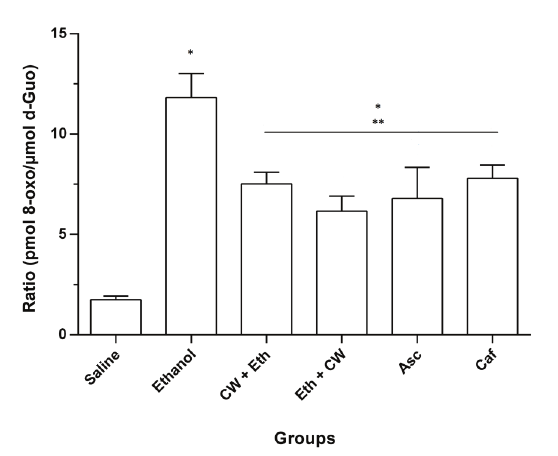
Figure 7 - Effect of CW, ascorbic and caffeic acid in the 8-oxo-2’-desoxiguanosinre DNA concentrations in liver of rats treated by ethanol. Eth – 2.5 mL/Kg of solution 35%; CW+Eth – 3 mL/Kg of coconut water followed by 2.5 mL/Kg ethanol; Eth+CW – 2.5 mL/Kg of ethanol followed by 3 mL/ Kg of coconut water; Asc + Eth – 3 mL/Kg of solution 25 µg/ µL followed by 2.5 mL/Kg of ethanol; Caf + Eth – 3 mL/Kg of solution 100 µg/µL followed by 2.5 mL/Kg of ethanol. The data are average ± S.D. for five animals. Means values were significant different for p<0.05; (*) different when compared with the saline group p<0.05; (**) difference with the ethanol group p<0.05. For multiple comparisons, ANOVA, followed by Dunnett’s test, were